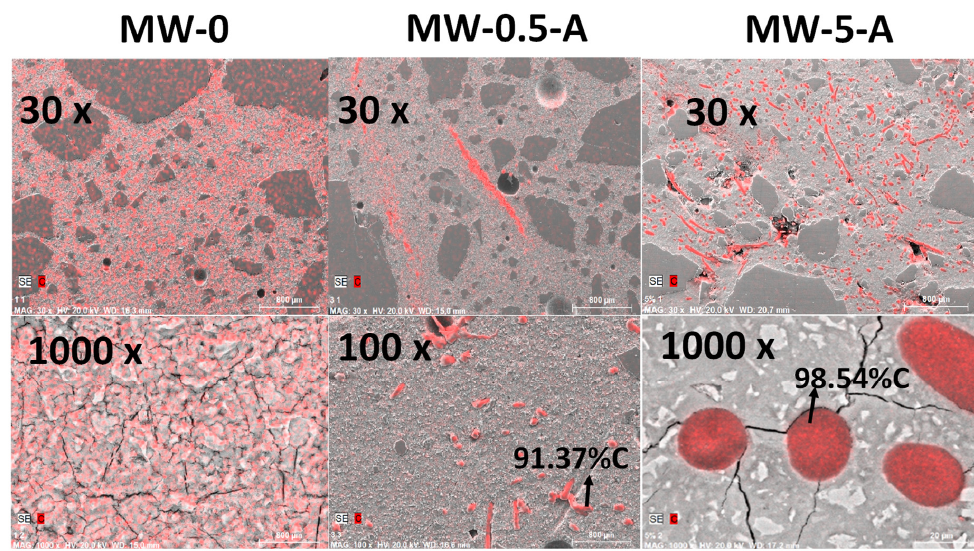
Figure 3. Elemental mapping images for carbon (in red) taken by BSE on golden metalized samples for different amounts of MW in the